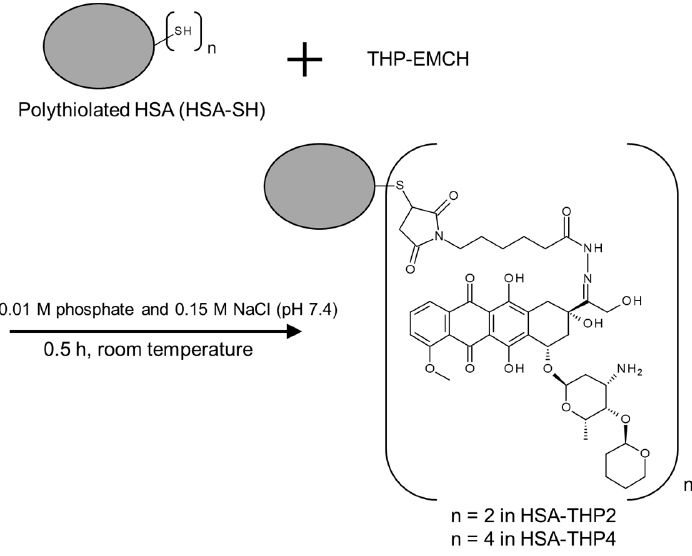
Figure 3. Synthesis of HSA-THP2 and HSA-THP4.